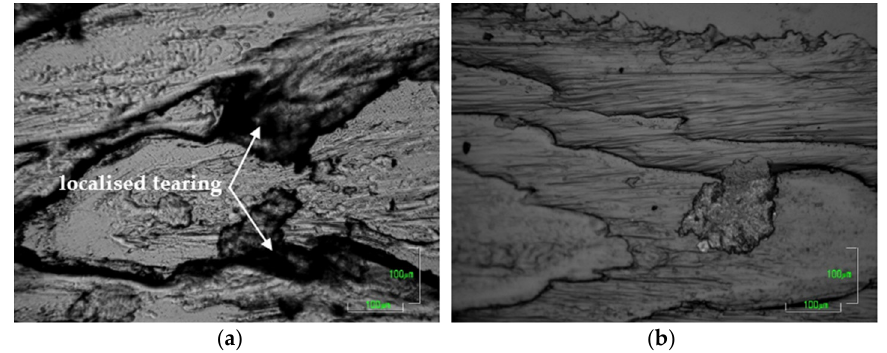
Figure 7. ( a ) Wear track of SH4 SIARL coating on soda ‐ lime glass after sliding for 500 m against stainless steel (30 cm/s–5 N); ( b ) Wear track of ULTRA 600 coating on soda ‐ lime glass after sliding for 500 m against stainless steel (30 cm/s–5 N).